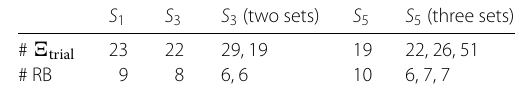
Table 1 Number of snapshots in the trial set for the different reduced basis (RB) for different solution S 1 S 3 S 3 (two